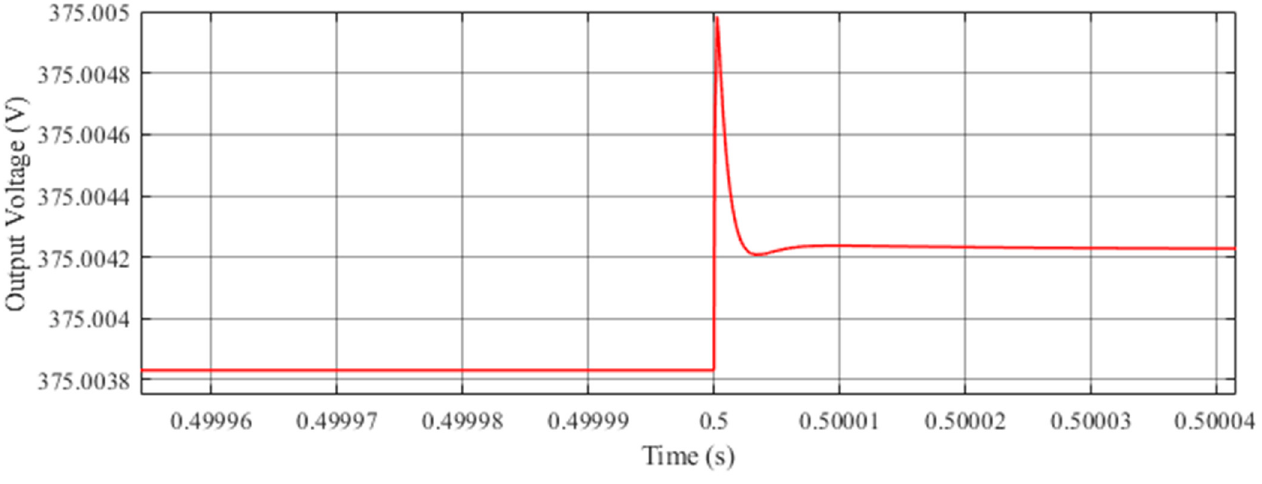
Figure 8. Output voltage of microgrid by NLIB controller in d - q frame zoomed-in view.